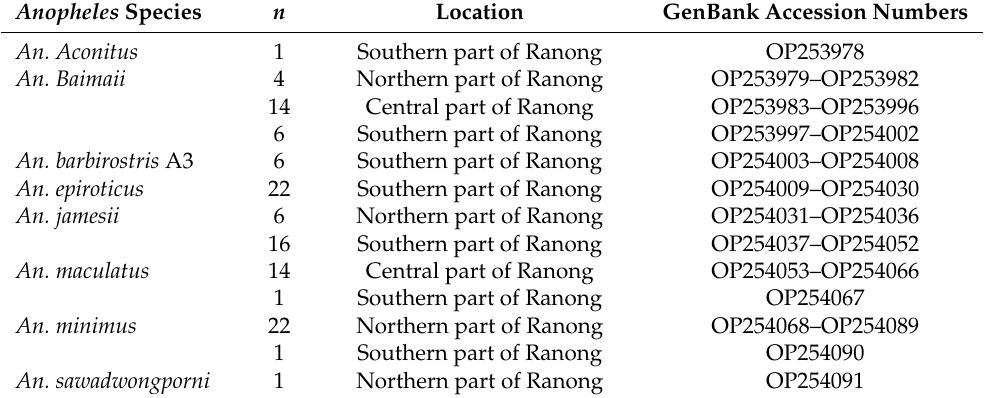
Table 2. GenBank accession numbers of COI sequences obtained in this study.